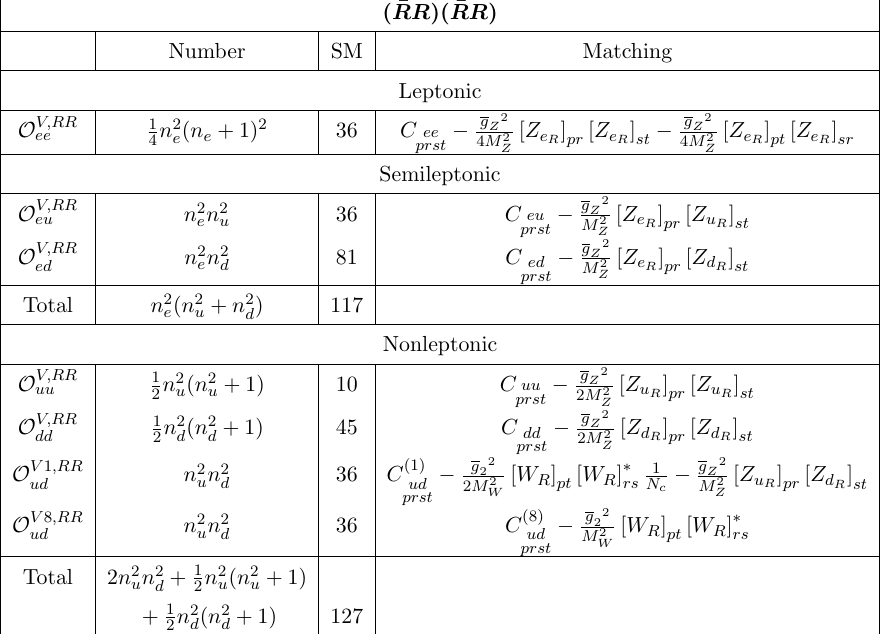
Table 14 . Dimension-six four-fermion operators: two right-handed currents in LEFT. The ( ¯ RR )( ¯ RR ) operators are divided into leptonic, semileptonic, and nonleptonic operators. The second column is the number of operators for an arbitrary number of charged lepton flavors n e , u -type quark flavors n u , and d -type quark flavors n d , and the third column is the number in the SM LEFT with n e = 3, n u = 2, and n d = 3. The last column is the tree-level matching coefficient in